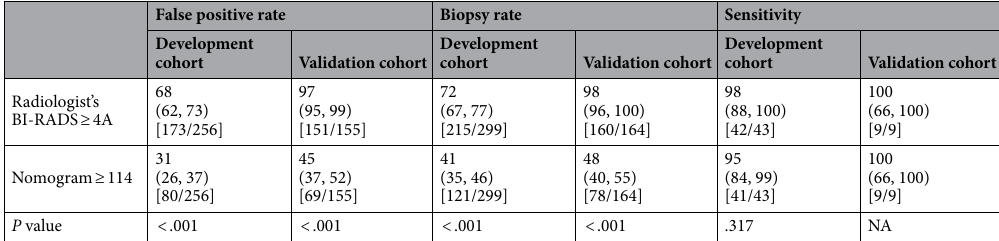
Table 4. Comparison of the false positive rate, biopsy rate, and sensitivity between the radiologist’s BI-RADS assessment and the proposed nomogram. Data in parentheses are the 95% confidence intervals, and the data in brackets are the numerators/denominators. BI-RADS, Breast Imaging Reporting and Data System.